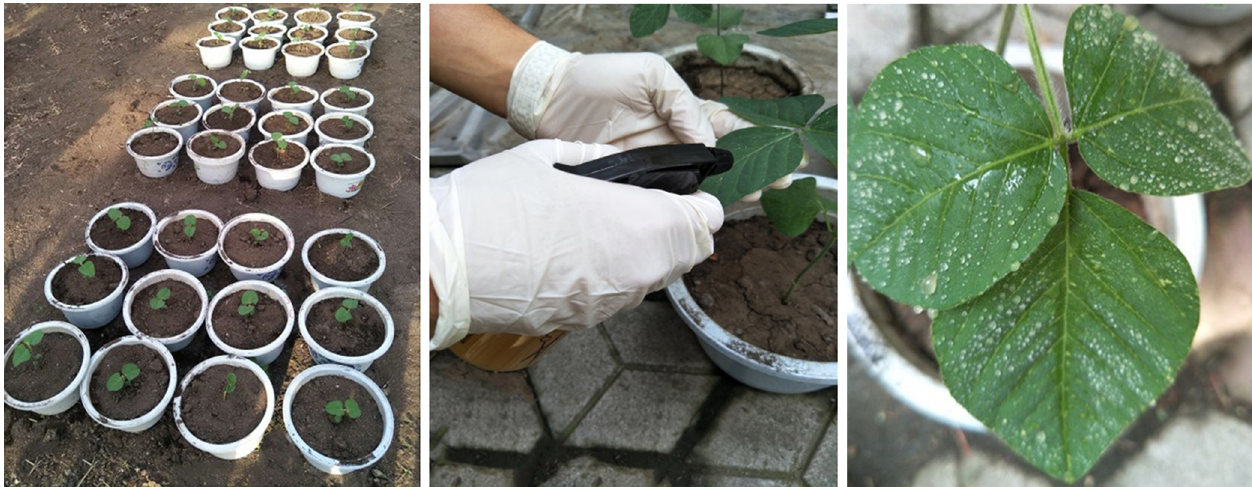
Fig 1. Representative images of soybean cultivation and inoculation. (a) Growing environment of soybean, (b) artificial inoculation, and (c) leaves post inoculation.